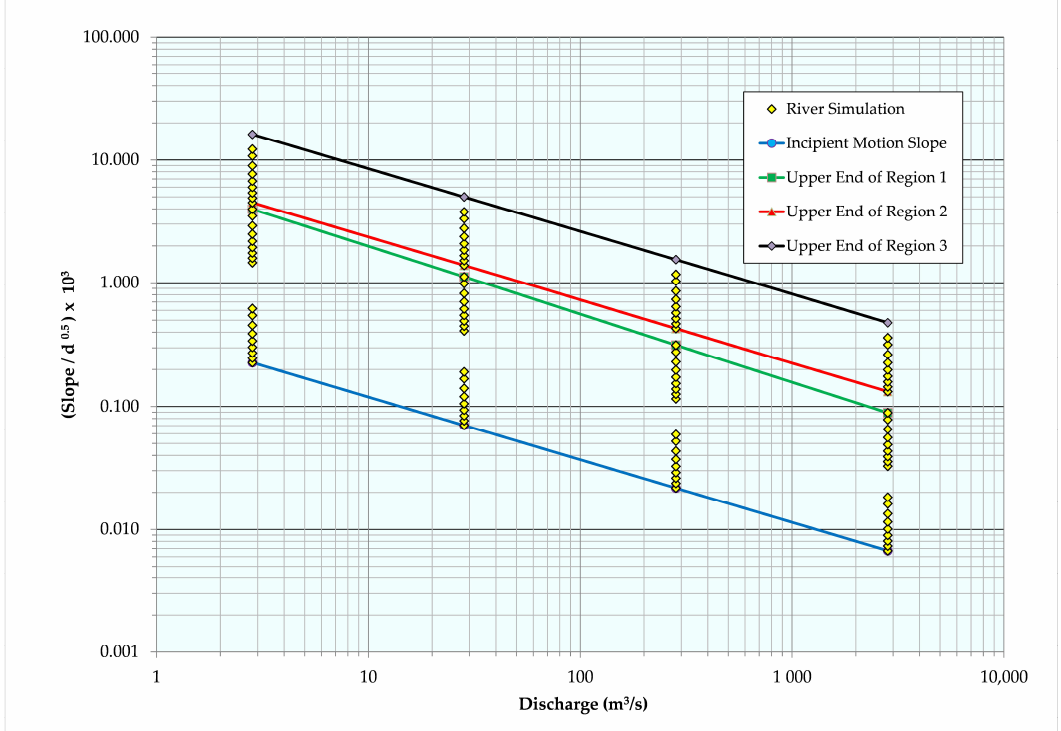
Figure 4. Twelve model simulation sets spanned three orders of magnitude of discharge (2.83, 28.3, 283, and 2832 m 3 / s), four orders of magnitude of longitudinal valley slope (7.11 × 10 − 6 to 2.69 × 10 − 2 ), and an order of magnitude in medium sediment grain size (0.125 to 4 m) (modified from Chang